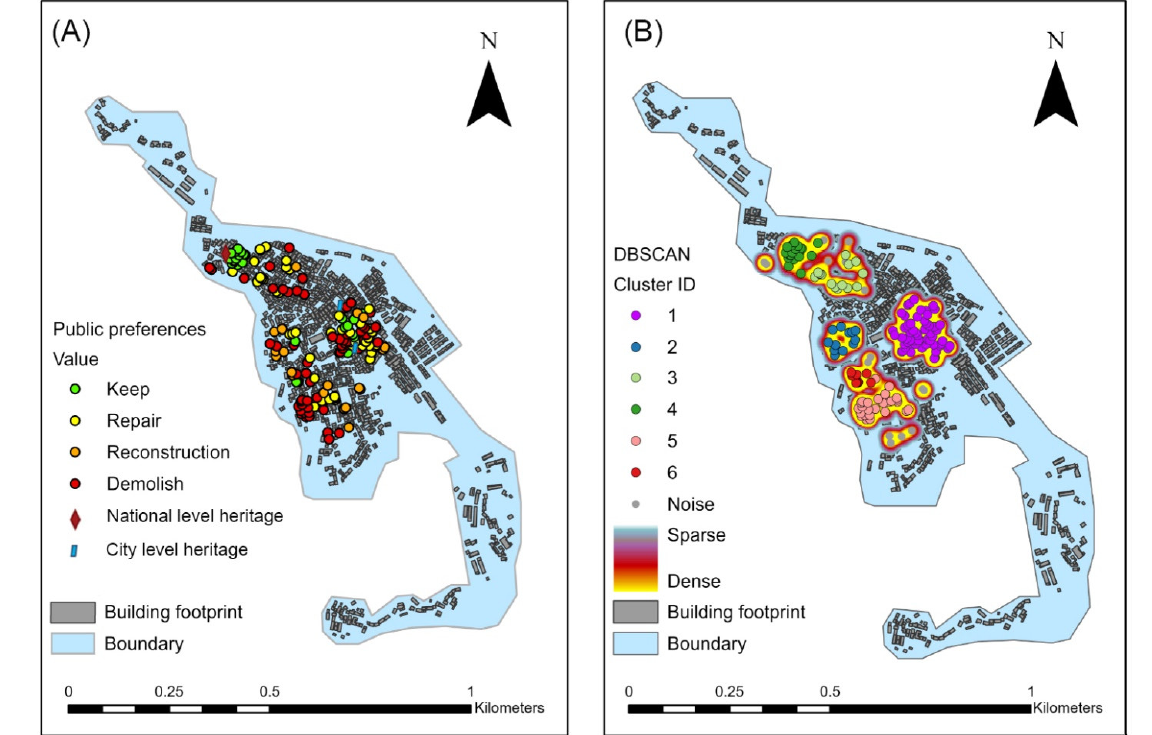
Figure 3. The spatial pattern of small spaces and individual buildings per micro-regeneration intervention type ( A ), and the clusters of all mapped point features based on their area densities ( B ).